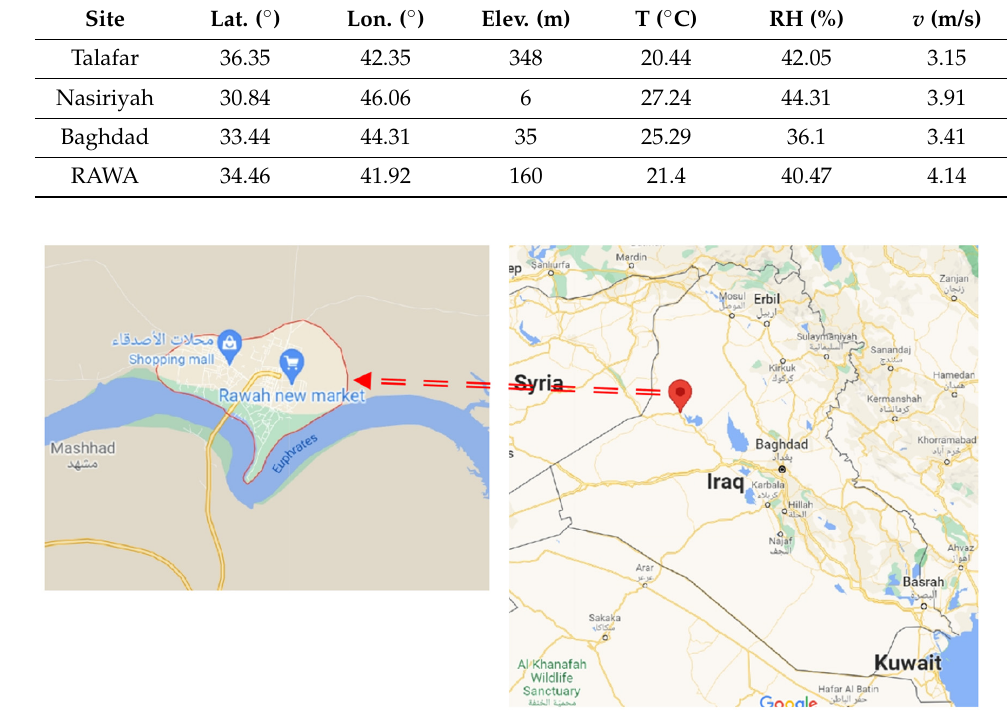
Figure 3. Location of study area (RAWA city).